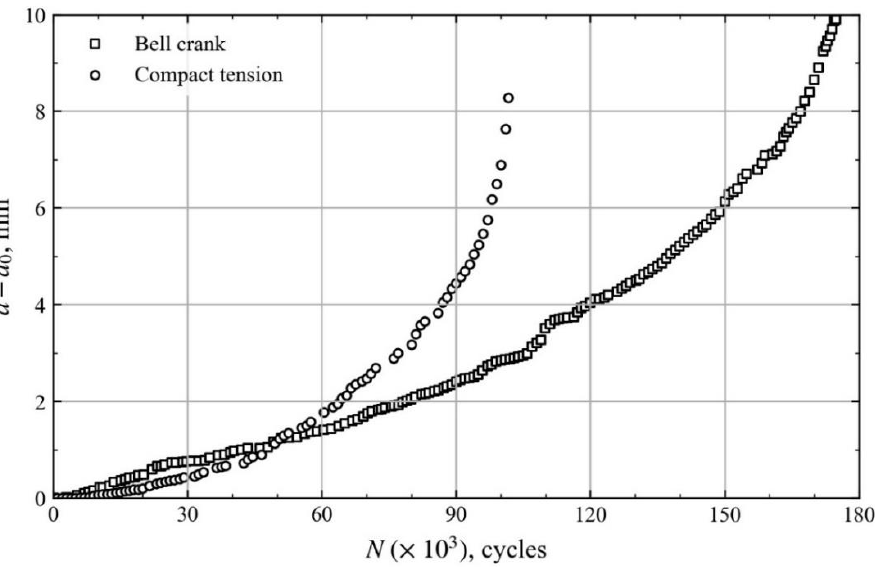
Figure 6. Fatigue crack growth curves of AISI 410 stainless steel measured using compact tension (C(T)) specimen and L-shaped bell crank